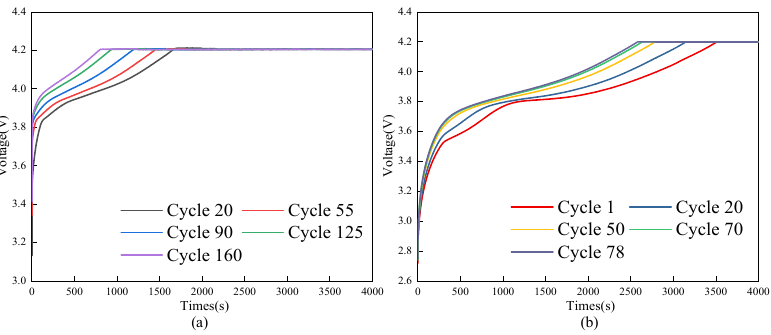
Figure 8. ( a ) charge voltage curves of B0005, ( b ) charge voltage of Cell 1.